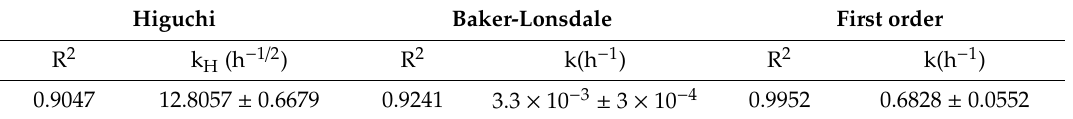
Table 3. Regression coe ffi cient (R 2 ) and rate constants (k H and k) of DCF release data